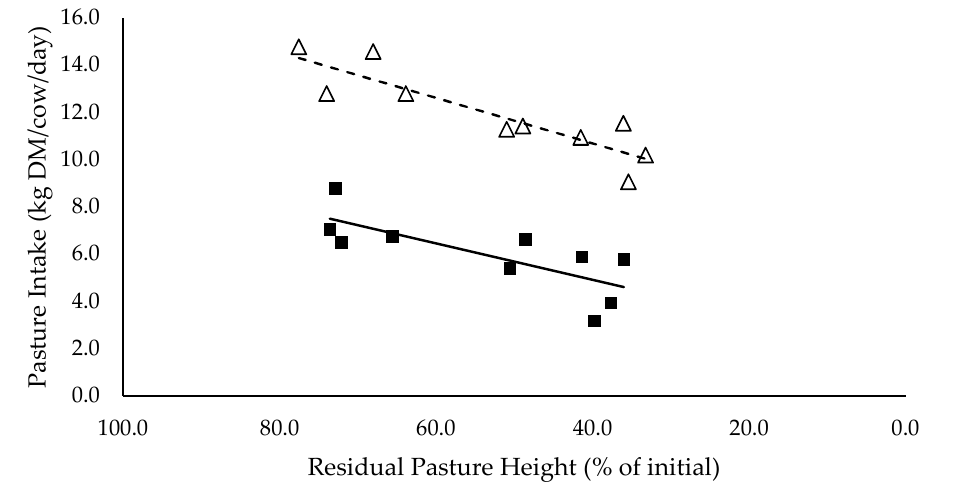
Figure 1. The relationship between pasture intake (kg DM/cow/day) and residual pasture height (% of initial) for high ( ■ ) and low (Δ) mixed ration levels. Lines were fitted for high (solid) and low (dashed) mixed ration levels.